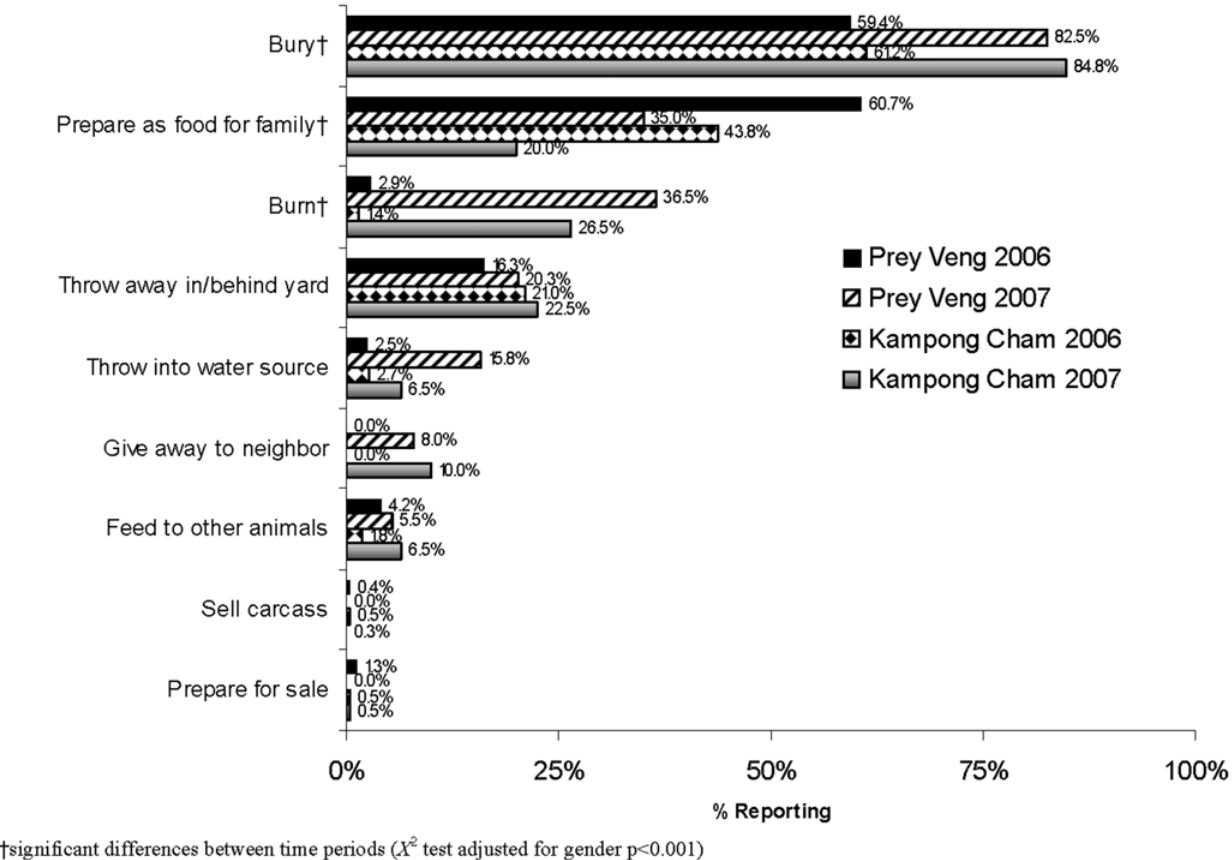
Figure 1. Changes in reported practices of poultry that died from illness in Kampong Cham and Prey Veng Provinces, Cambodia from January 2006 to December 2007. { significant differences between time periods ( X 2 test adjusted for gender p , 0.001).